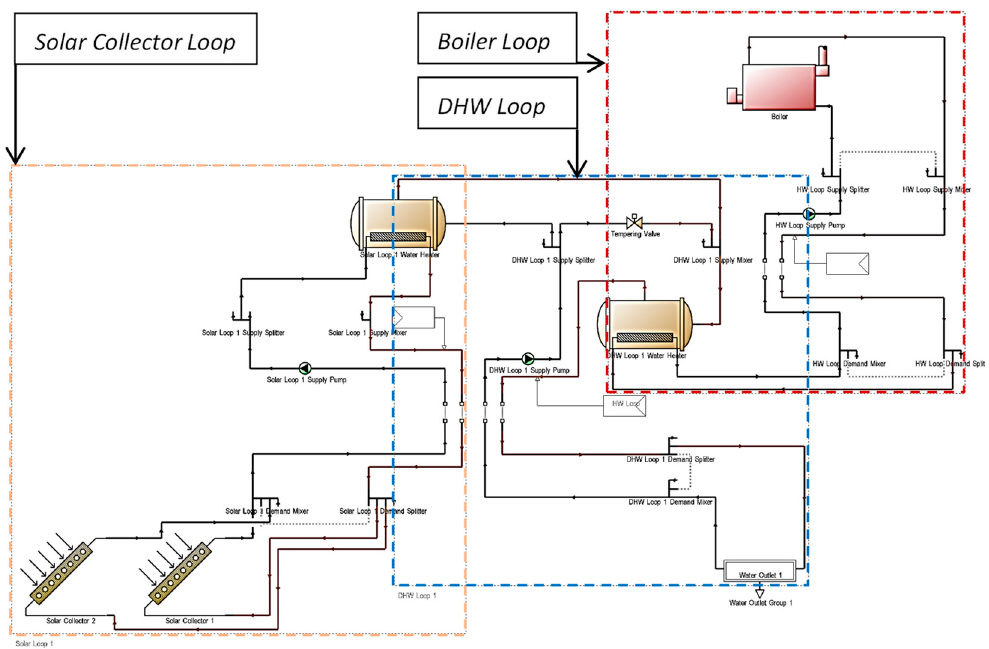
Figure 4. The solar domestic hot water system composed of solar thermal collectors, pumps, a water storage tank and a water heater.